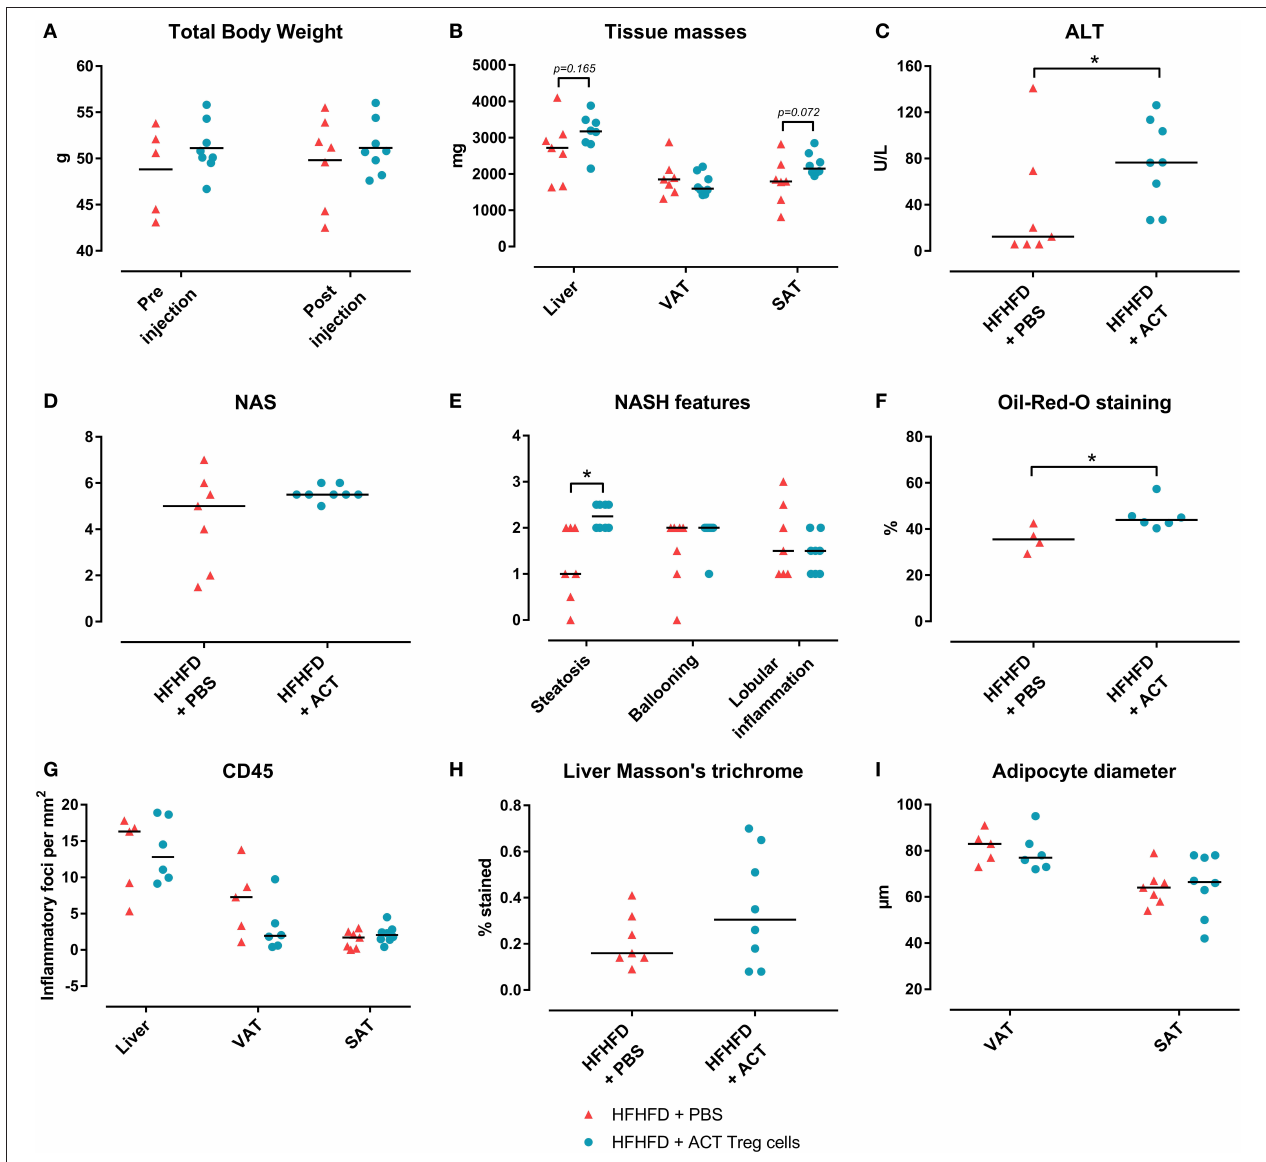
FIGURE 3 | The effect of adoptive Treg cell transfer on metabolic disruptions and NASH. (A) Total body weight before and after injection (B) Tissue masses. (C) Plasma ALT levels. (D) NAS. (E) NASH features. (F) Quantification of hepatic steatosis through Oil-red-O staining, expressed as percentage stained. (G) Quantification of hepatic and adipose tissue inflammation through CD45 immunohistochemistry, expressed as number of inflammatory foci per mm 2 . (H) Quantification of fibrosis on MT-stained liver tissue, expressed in percentage stained. (I) Adipocyte diameter. Medians are depicted with a horizontal black line. * P < 0.05 (Mann Whitney U). ACT, adoptive cell transfer; ALT, alanine transaminase; HFHFD, high-fat high-fructose diet; NAFLD, non-alcoholic fatty liver disease; NAS, NAFLD activity score; NASH, non-alcoholic steatohepatitis; PBS, phosphate-buffered saline; SAT, subcutaneous adipose tissue; Treg, regulatory T; VAT, visceral adipose